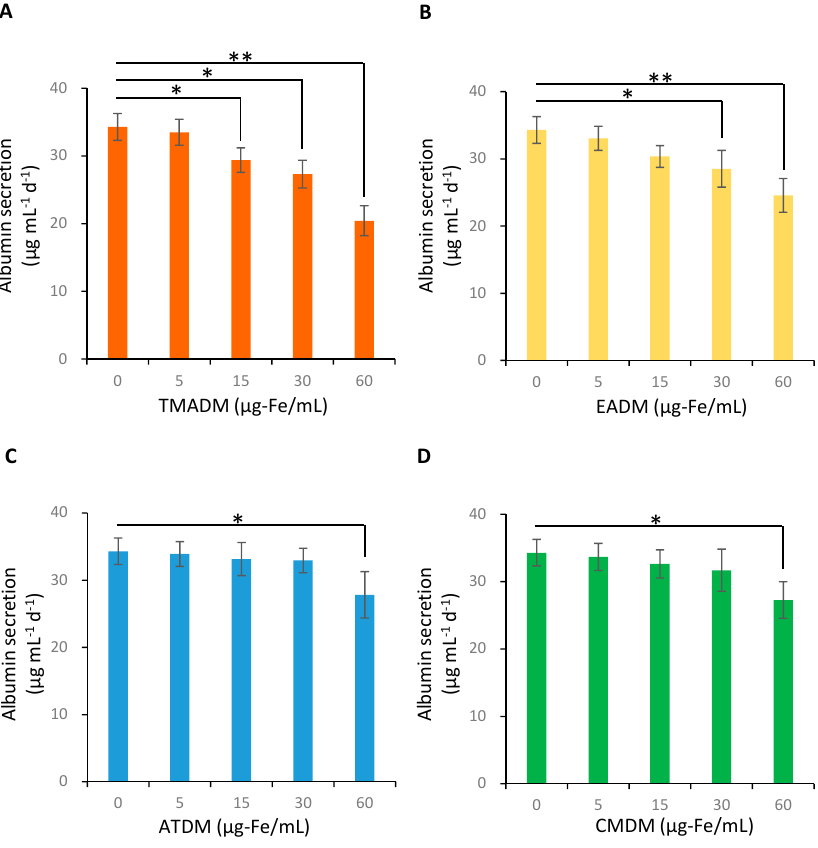
Figure 5. Albumin secretion of hepatocyte–endothelial cell heterospheroids labeled with polysac‑ charide magnetic iron oxide nanoparticles. The type of nanoparticle: ( A ) TMADM; ( B ) EADM; ( C ) ATDM; ( D ) CMDM. The heterospheroids were incubated for 2 d at 37 °C. After 48 h of cell culture, the heterospheroids were then incubated with various nanoparticles (0, 5, 15, 30, and 60 μ g-Fe/mL) for 24 h at 37 °C. The albumin secretion by heterospheroids on day 3 was measured with ELISA. The data shown represent the means and SD of three independent experiments. p ‑values are presented. Welch’s t ‑tests were used to compare albumin secretion of the control group (non‑labeled heterospheroids, 0 μ g-Fe/mL) vs. the labeled groups. No mark = no significance, * p < 0.05, ** p < 0.01.